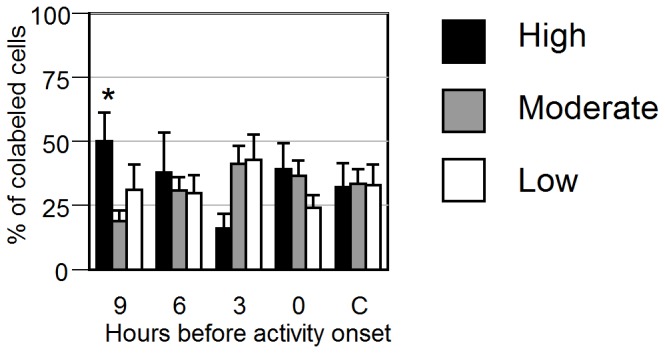

Per1 intensity quantified by category of intensity within TH cells.Distribution of cells expressing high (black), moderate (grey) or low (white) levels of Per1 in the TH-expressing cells of the LC. * P<0.05 vs. 3 hours before activity onset.